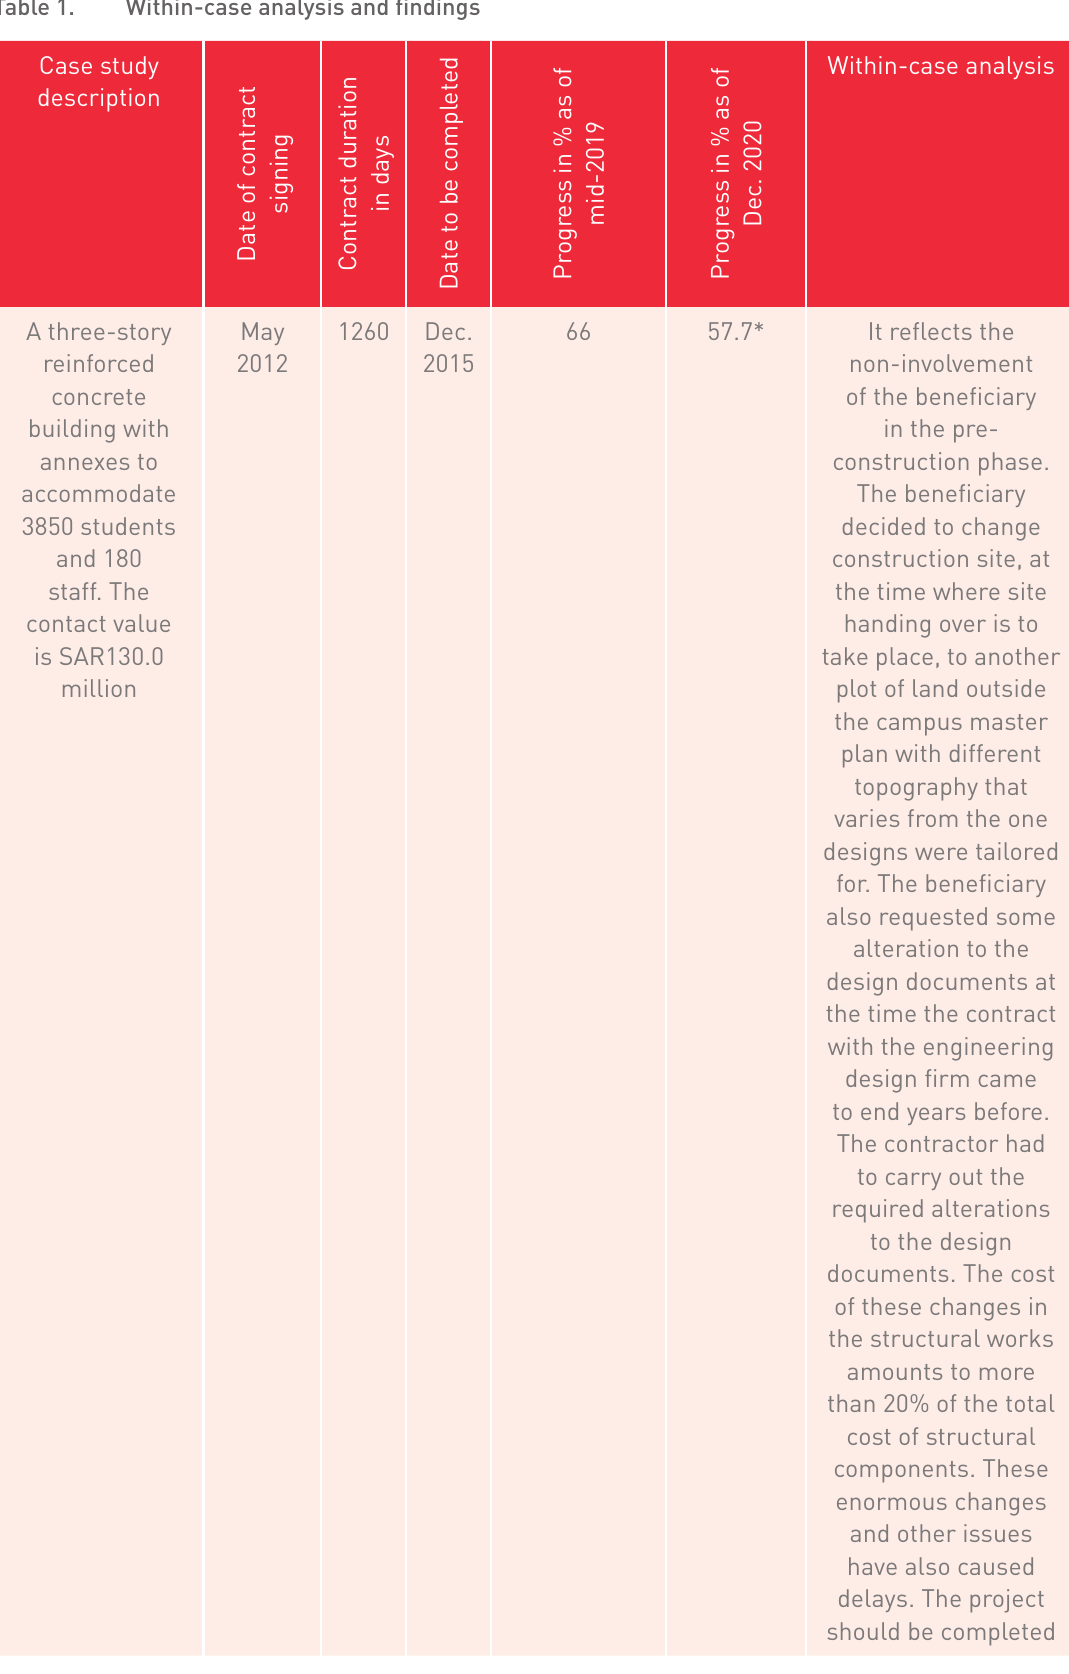
Within-case analysis and